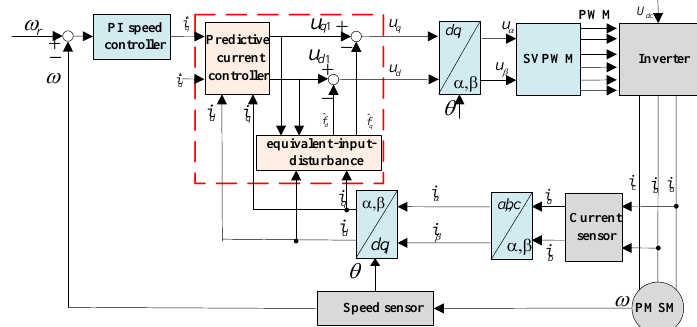
Figure 1. Block diagram of permanent magnet synchronous motor (PMSM) control